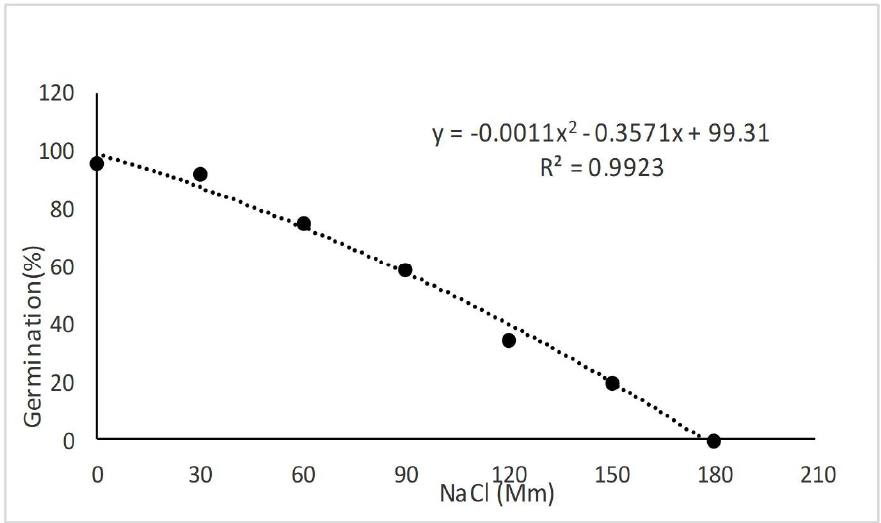
Figure 4. Effects of salinity stress on the GP of Hibiscus tea